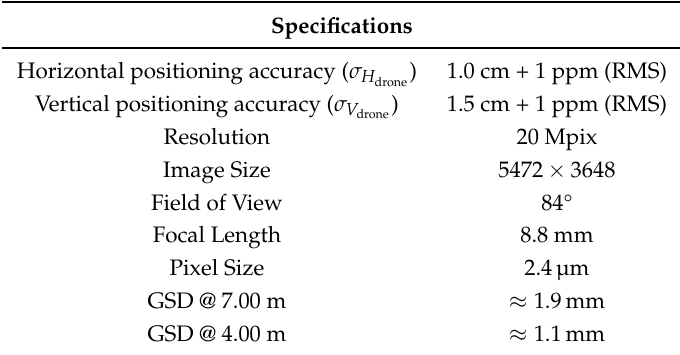
Table 1. Aircraft technical